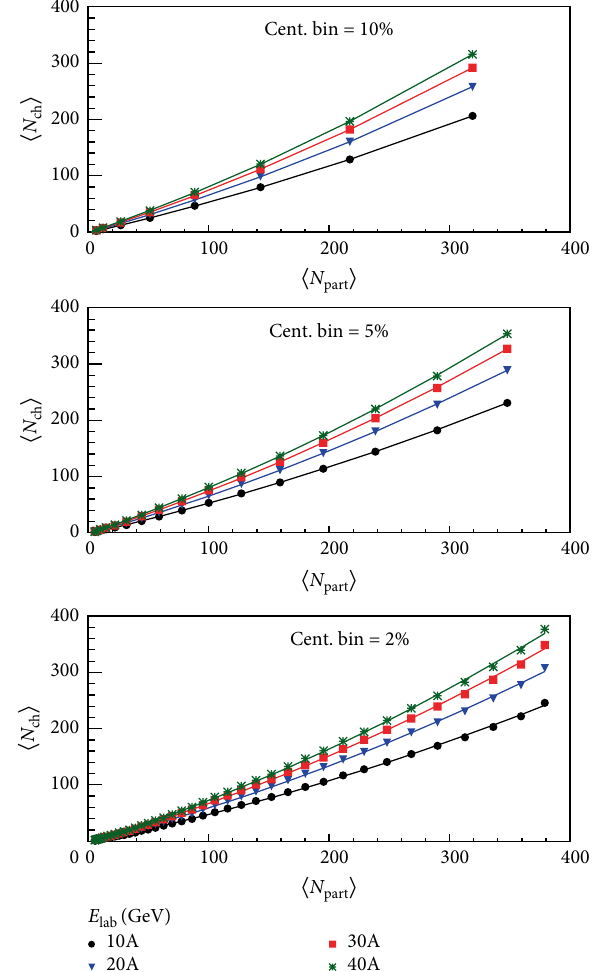
Figure 2: Variations of mean multiplicity with mean number of participating nucleons. The lines are due to fits obtained using equation